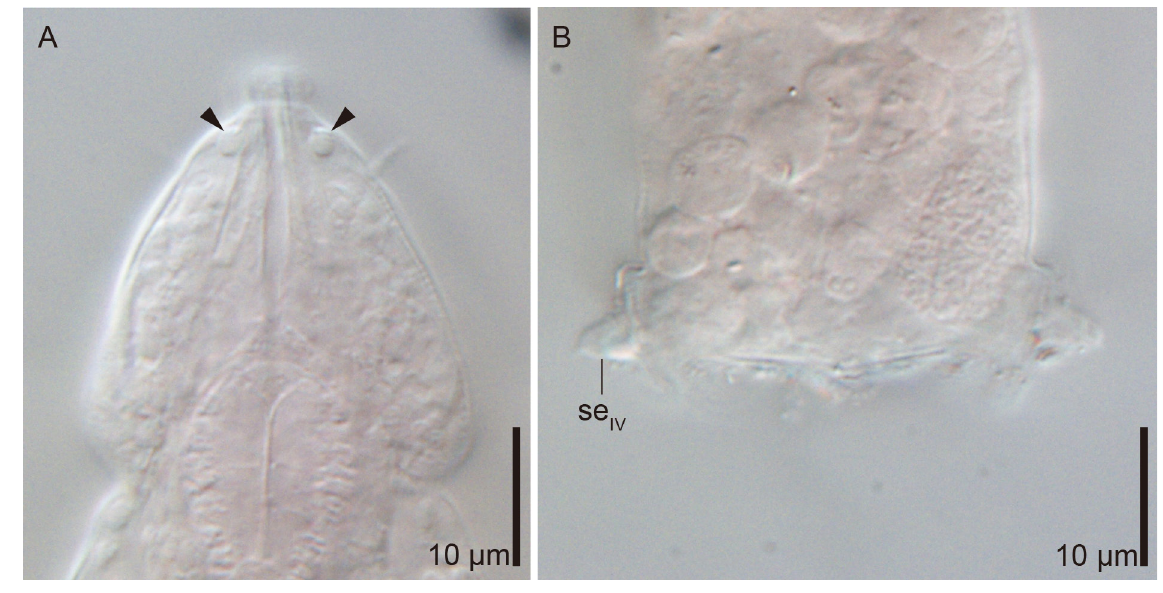
Fig. 5. Micrographs of Angursa capsula Bussau, 1992 (SMF 28). A . Cephalic region with paired globular bodies (black arrowheads). B . Caudal